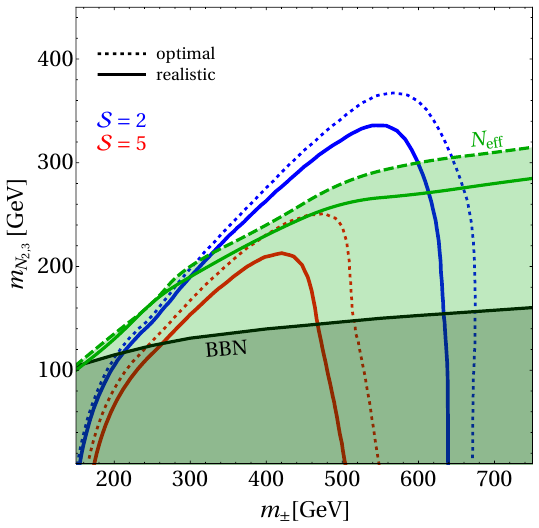
Figure 8 . Projected sensitivities for HL-LHC using = 4000 fb (cid:0) 1 and the same analysis techniques L as [55]. Given in blue are exclusion limits, = 2, and shown in red are discovery limits, where S = 5. The dashed lines correspond to optimal branching ratio into leptons, whereas to obtain the S solid lines we used the value for NO given in table 5. HNL masses in the black shaded region are in con(cid:13)ict with BBN constraints discussed in section 3.4 and the green lines arise from N e(cid:11) limits: the dashed green line indicates conservative and the solid one represents aggressive limit. The latter are stronger for di-lepton searches in contrast with the di-tau